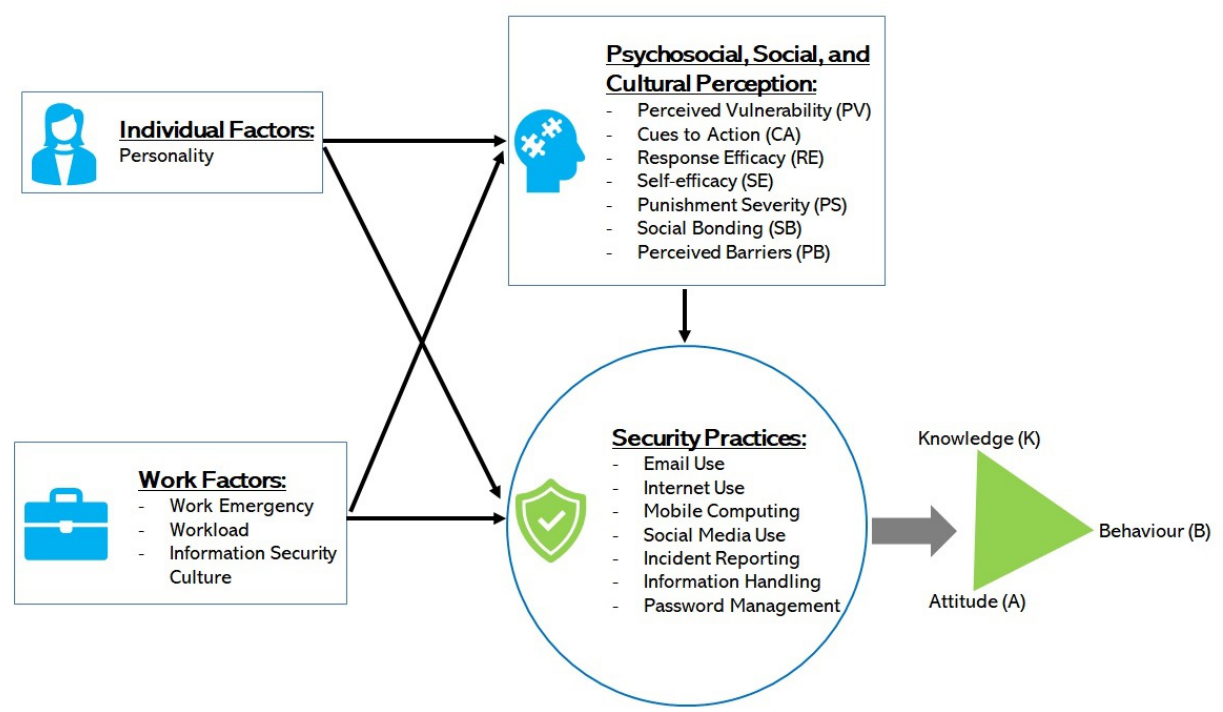
Figure 1. The study